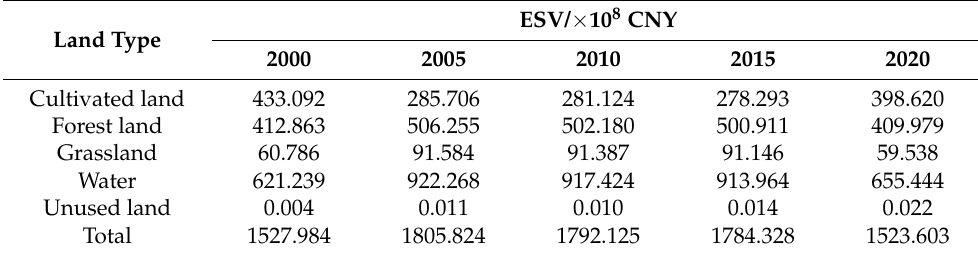
Table 2. Total ESV of the Nanjing metropolitan area.